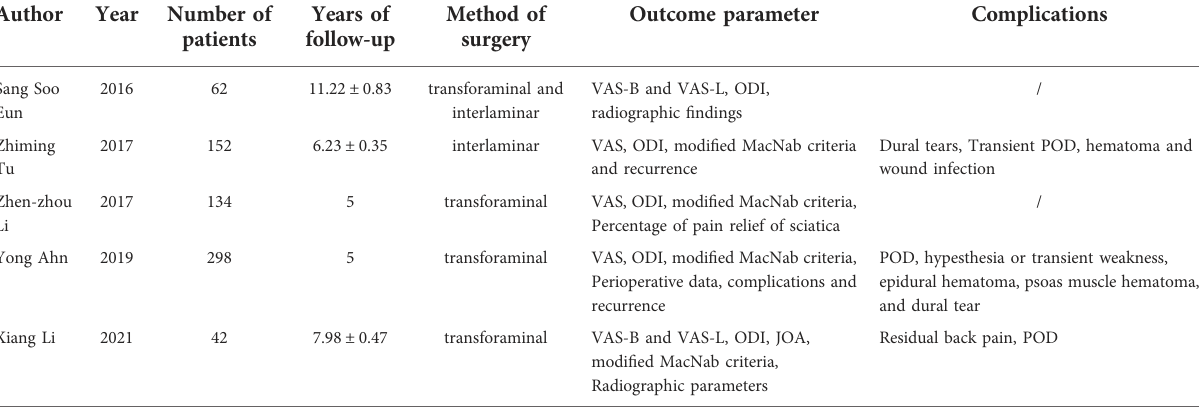
TABLE 6 Basic situation of Mid and long-term term outcomes (>5 years) reported in domestic and foreign literature.